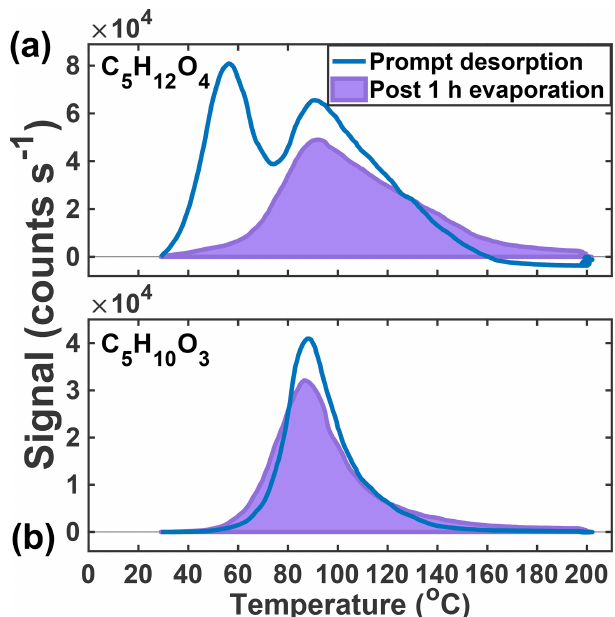
Figure 5. Thermograms obtained from prompt desorption of the aerosol (blue) and after 1h of evaporation (lavender, shaded) of the two major particle-phase compounds detected in the chamber: C 5 H 12 O 4 (a) and C 5 H 10 O 3 (b)